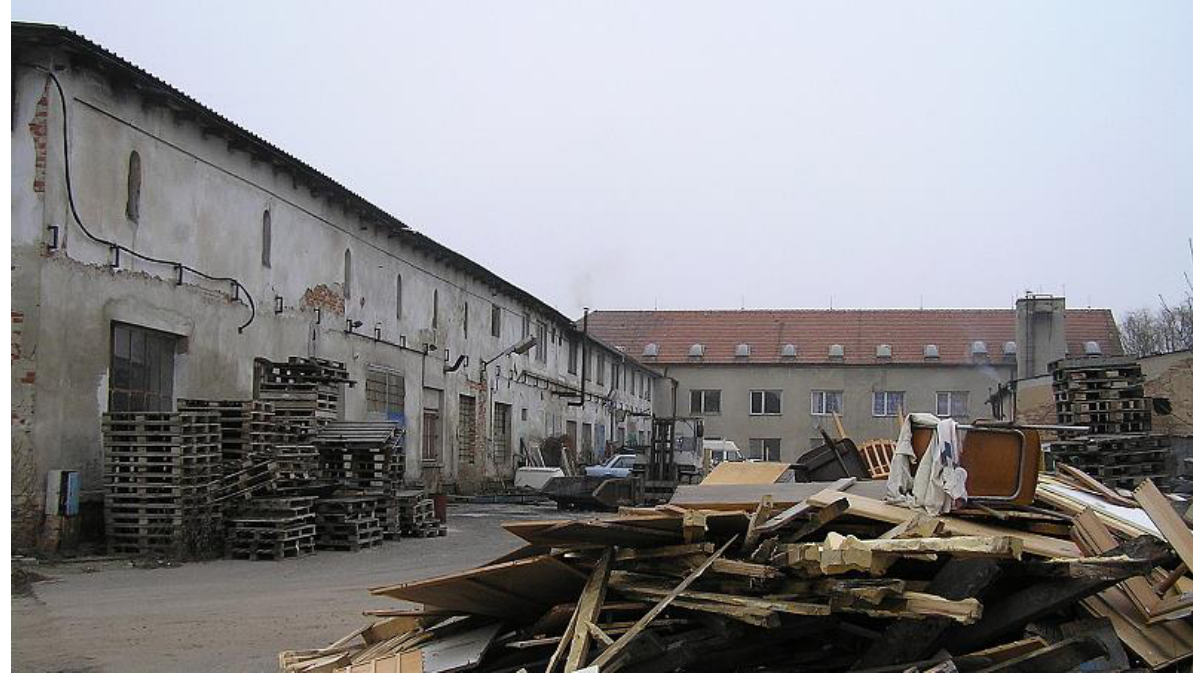
Figure 2. A view of the production part of the former socialist agricultural cooperative farm in Vranovice at the start of the regeneration process. Source: [59].